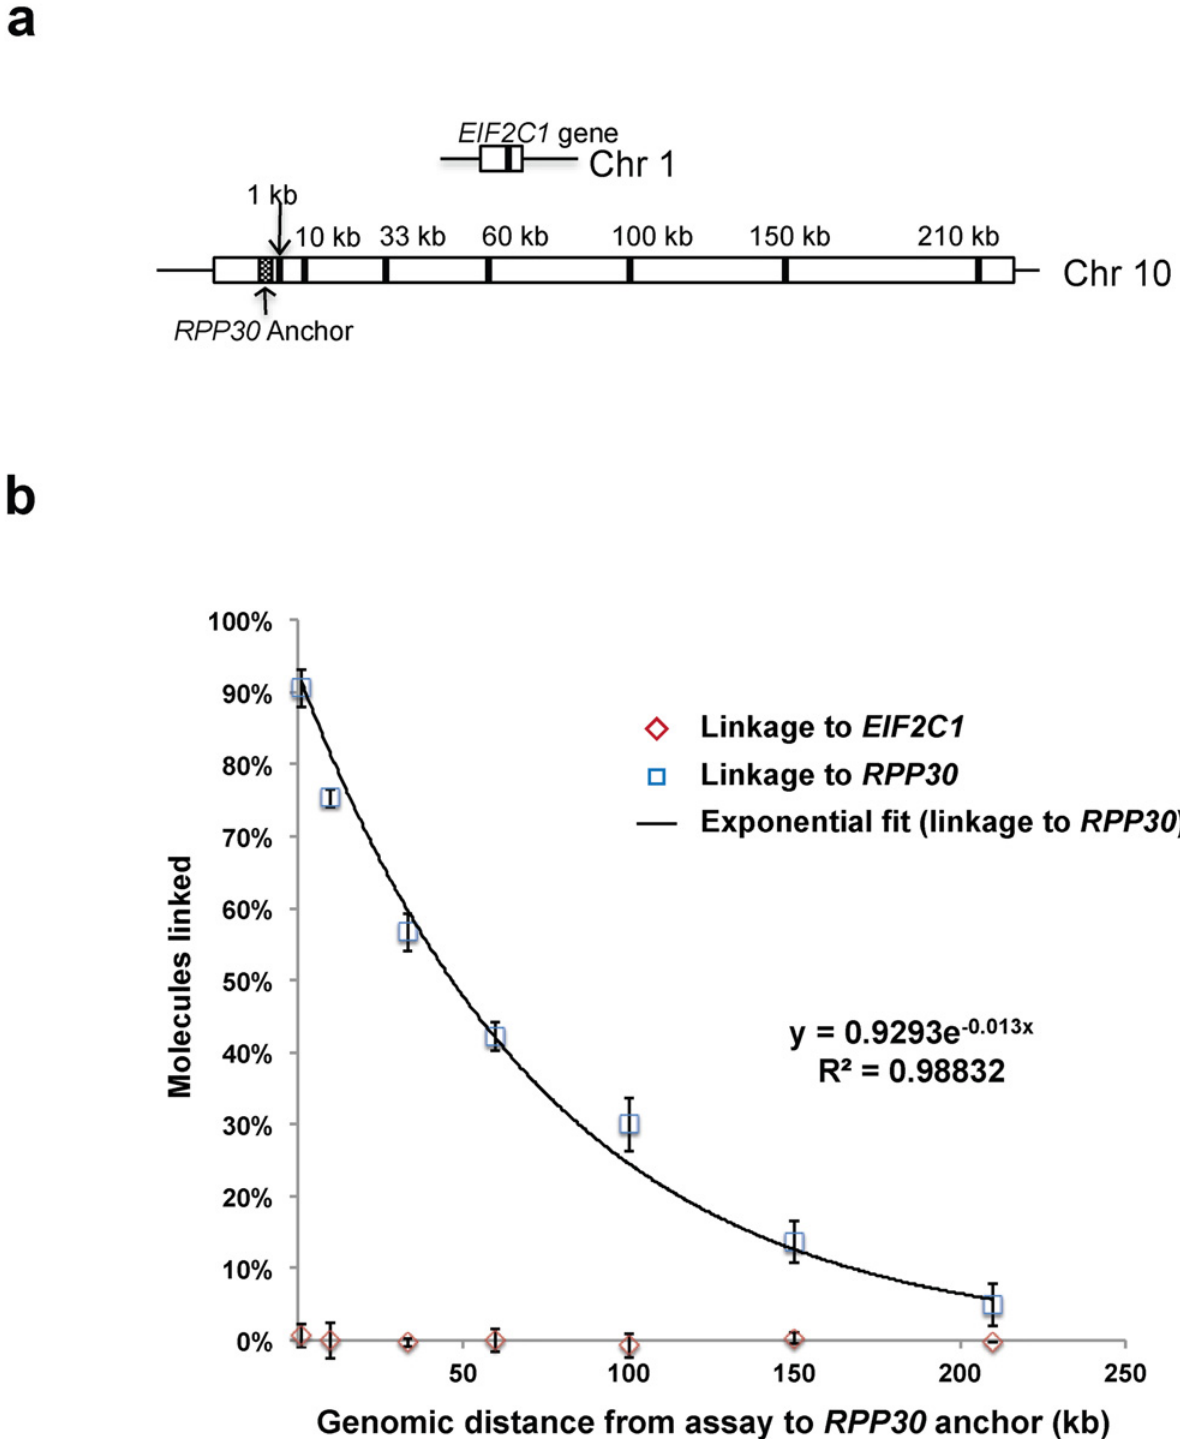
Fig 2. Evaluation of the relationship of physical linkage to genomic distance, using polysaccharide precipitation-extracted DNA. ( a ) In this analysis, FAM-labeled “ mile marker ” assays targeting sequences at different distances (1 – 210 kb) from the RPP30 anchor sequence were paired with a HEX-labeled assay specific to the RPP30 anchor sequence. Control assays utilized an anchor assay sequence in EIF2C , which resides on another chromosome. ( b ) The percentage of linked molecules at each genomic distance is shown as a function of distance. Means (of triplicate measurements) and 95% confidence intervals are